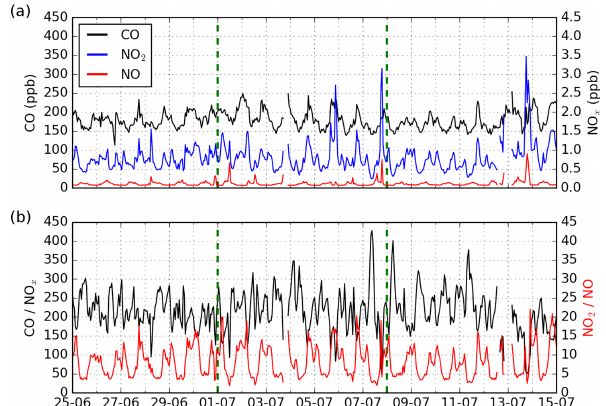
Figure A4. Time series of (a) carbon monoxide (CO), nitrogen dioxide (NO 2 ), and nitrogen monoxide (NO) hourly concentrations (ppb) observed at Savè (Benin) over the entire campaign period (25 June to 15 July 2016) and (b) of the ratios CO / NO x (in black) and NO 2 / NO (in red). The studied period (1–7 July 2016) is defined by the two green dashed vertical lines.